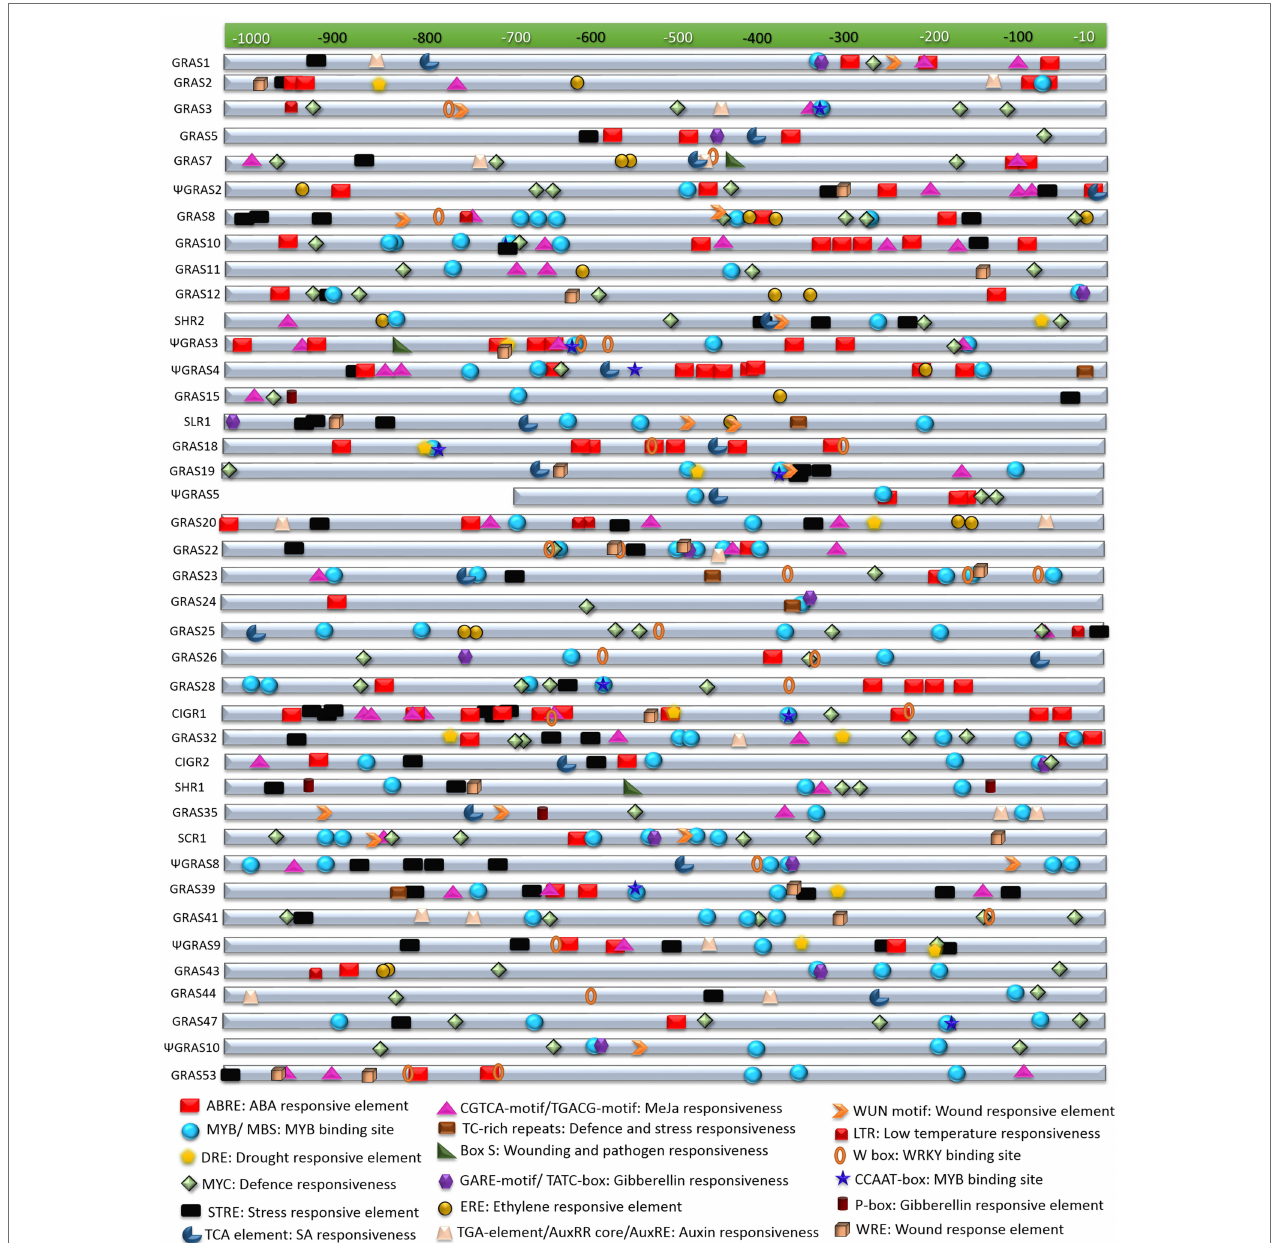
FIGURE 4 | In-silico analysis of putative promoter regions of GRAS genes. The selected GRAS genes were subjected to in silico analysis for cis -regulatory elements in their putative promoter regions (sequence retrieved from about ≤ 1 kb upstream region). This was performed in PlantCARE database and the figure was prepared by mapping the stress regulatory elements in the each of the sequences. The index for each element along with its functions are mentioned below the